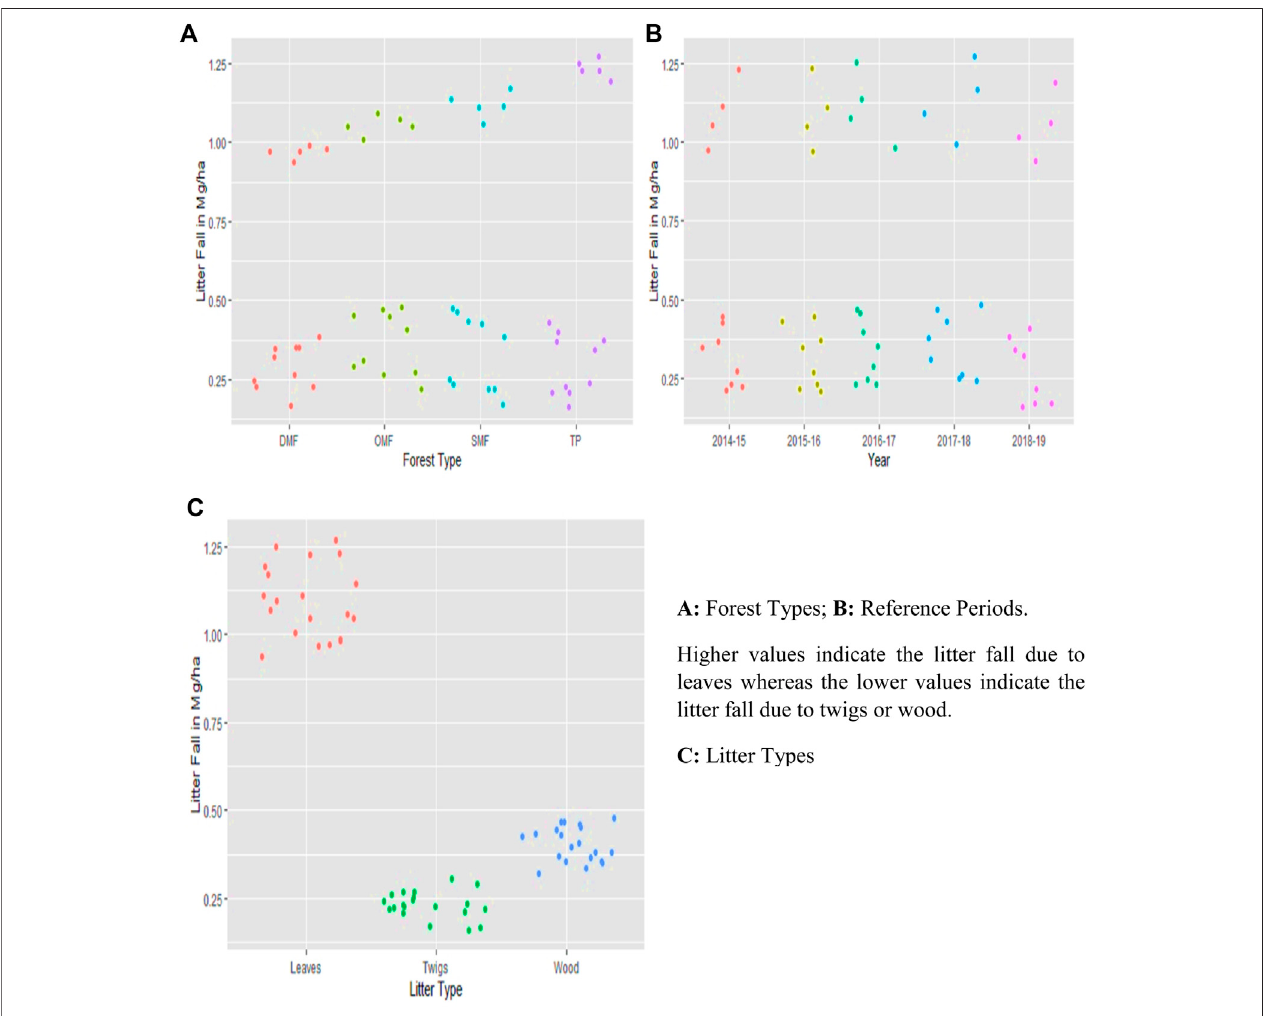
FIGURE 4 | Litter fall observation for understanding sustainable bioeconomic patterns in parameters. (A) : forest types; (B) : reference periods. Higher values indicate the litter fall because of leaves, whereas the lower values indicate the litter fall because of twigs or wood. (C) : litter types.